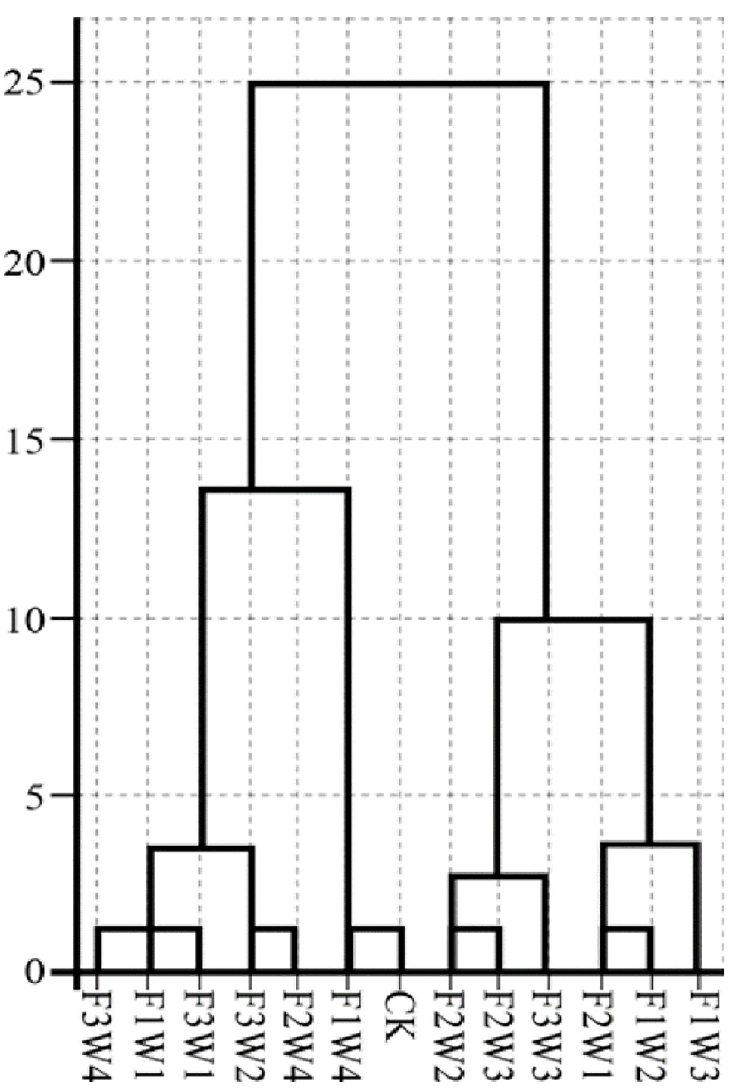
Fig 1. Cluster analysis of various water and fertilizer combinations. Treatment abbreviations are defined in Table 1.